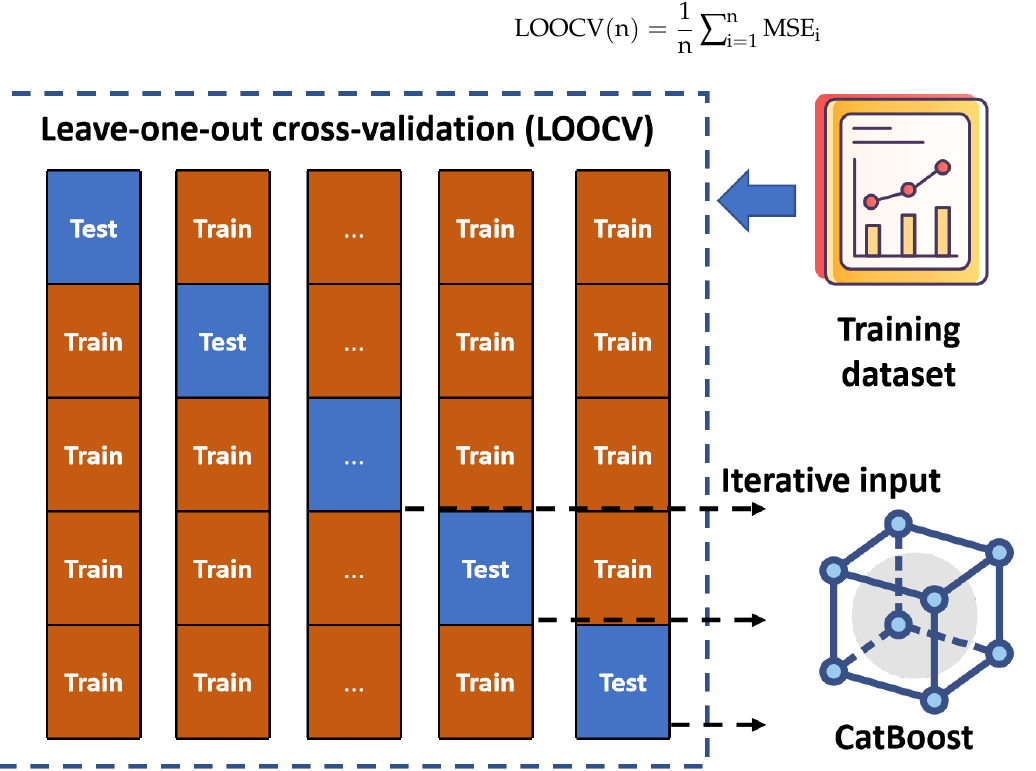
Figure 7. Leave-one-out cross-validation implementation process. Four evaluation measures were selected to indicate the performance of the CatBoost model.